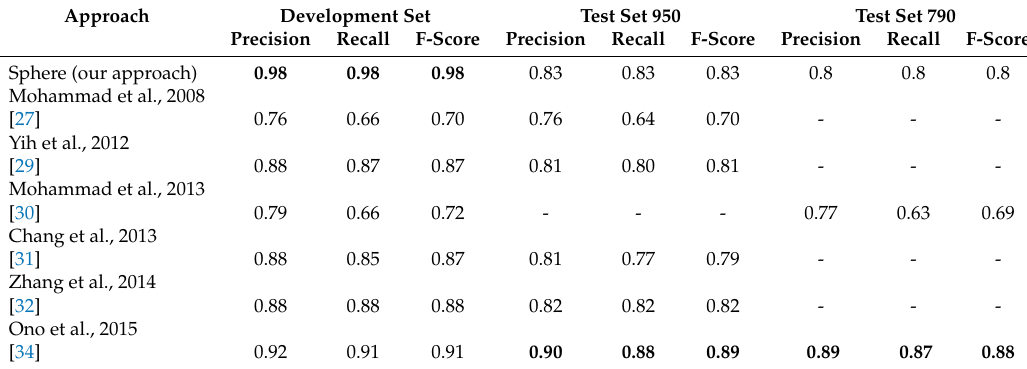
Table 4. Results of closest-opposite